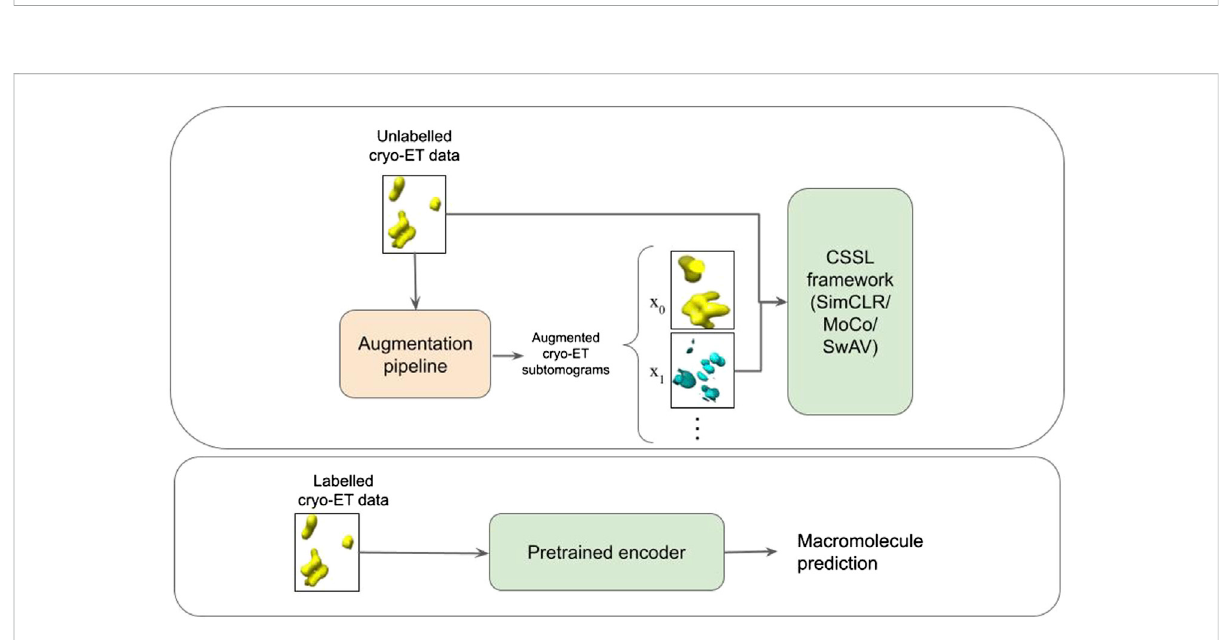
FIGURE 2 Schematic illustration of the pipeline. The fi rst box represents the CSSL pretraining process. An augmentation pipeline is used to create augmented cryo-ET images which is then fed into a CSSL framework to perform CSSL pretraining. The pretrained encoder is then fi ne-tuned using labelled cryo-ET data as shown in the second